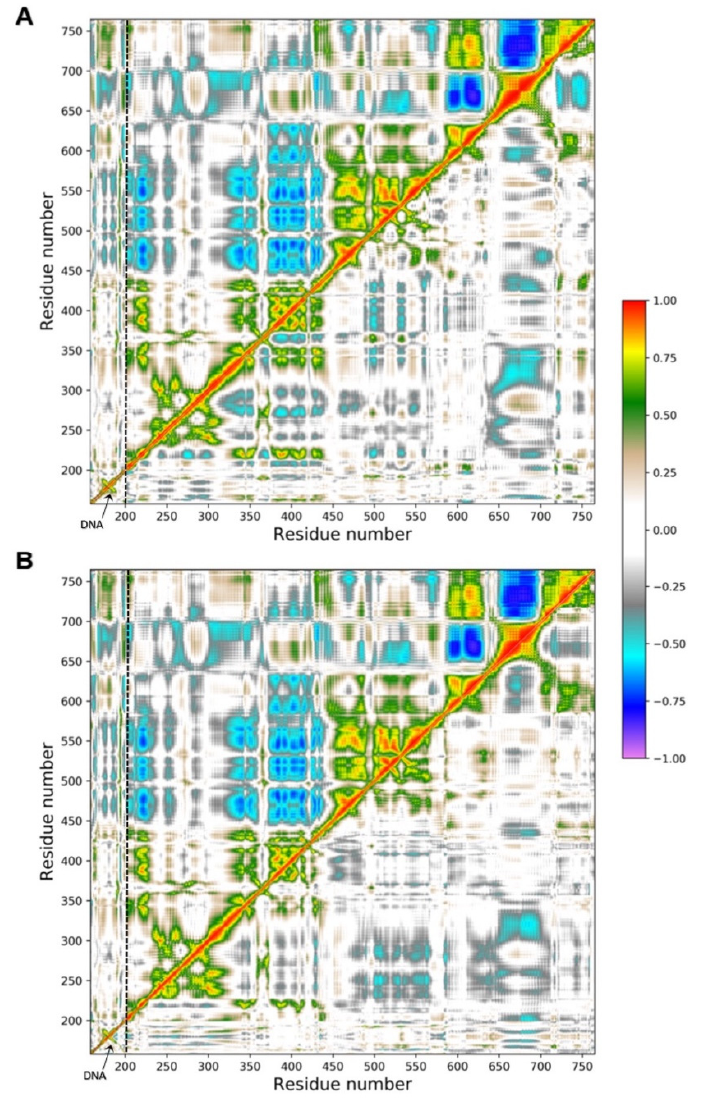
Figure 6. DCCMs obtained for the three simulated systems. The upper-left triangles of both graphs ( A , B ) represent the DCCM obtained for the unbound htopIB-DNA complex, while the lower-right triangles show the DCCMs for the non-intercalated ( A ) and intercalated ( B ) drug complexes, respectively. Color coding is reported in the legend. Positive values between two residues indicate a correlated motion, while negative values indicate an anti-correlated motion. DNA regions are indicated by labels and separated from the protein regions by dotted lines.